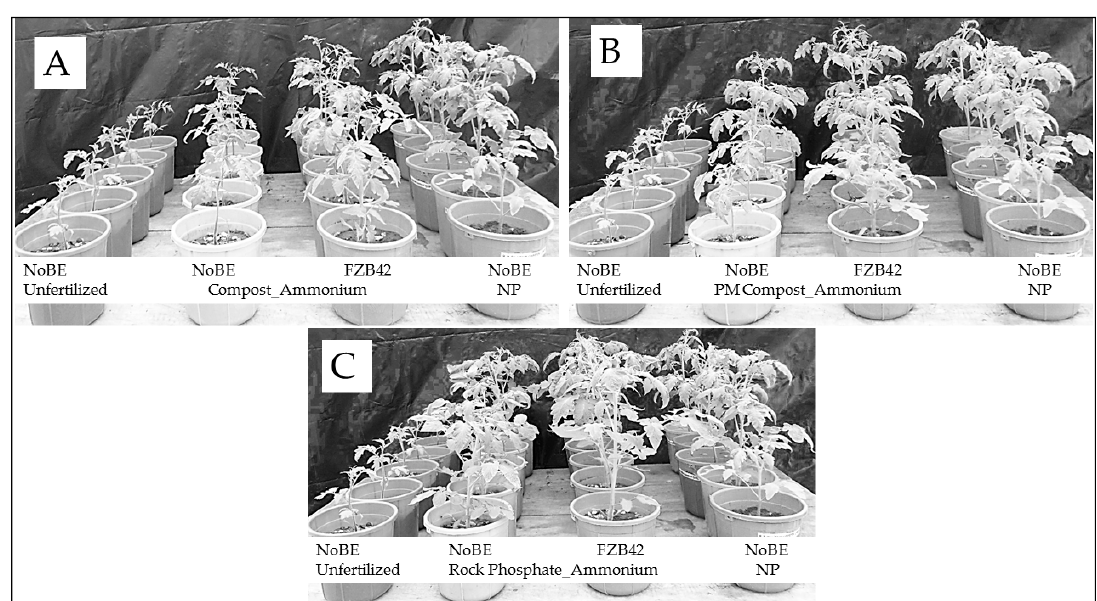
Figure 5. Plant growth of 4-week-old tomato on pH 5.6 soil supplied with different fertilizers and with and without Bacillus velezensis FZB42 inoculation ( A ) PM compost ( B ) and rock phosphate ( C ) (NoBE = no bioeffector, PM = poultry manure, NP = calcium nitrate plus superphosphate). Agronomy 2018 , 8 , x FOR PEER REVIEW